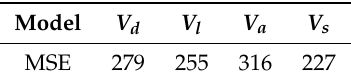
Table 2. Mean squared error (MSE) calculated between A. aegypti abundance data and the predictions from our suite of models for the mosquito density V d , V l , V a , and V s